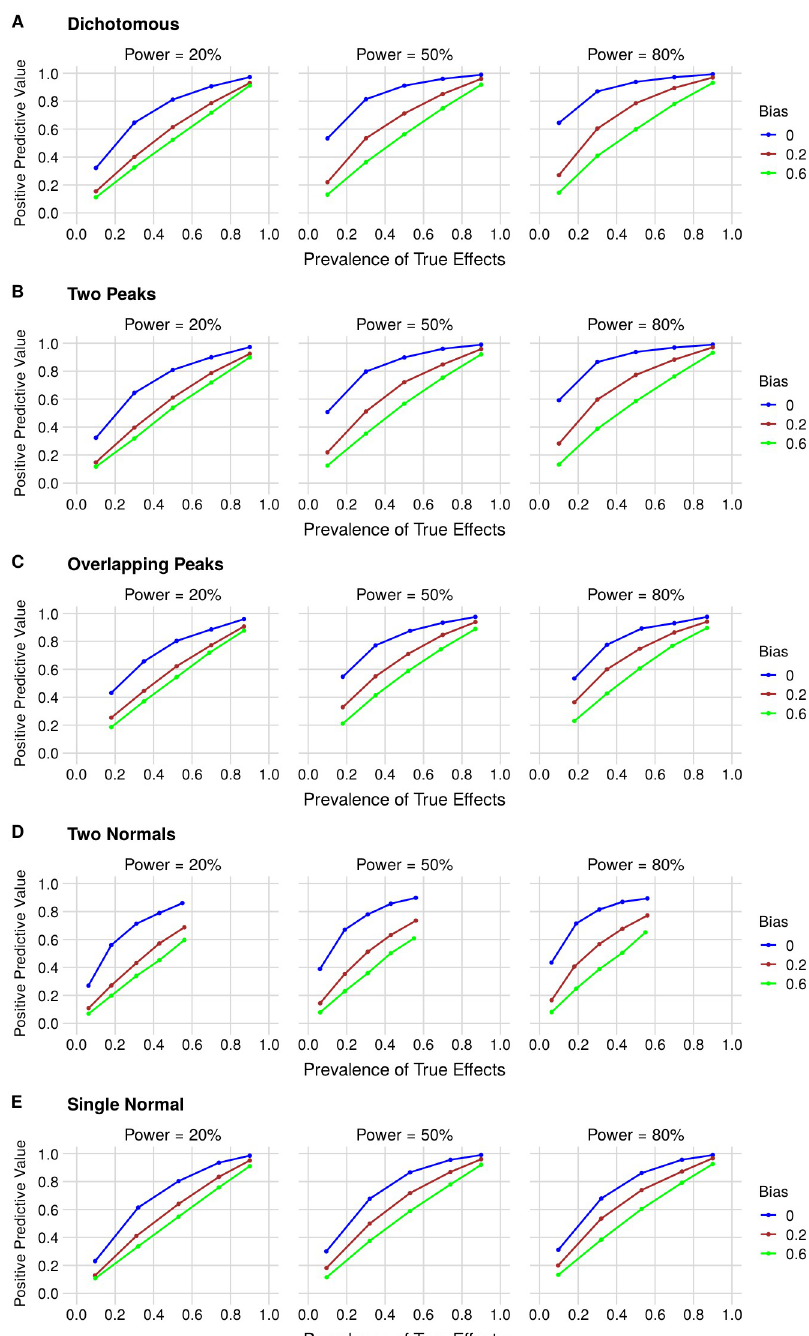
Fig 2. PPV as a function of the prevalence of true effects, statistical power and bias for (A) Dichotomous, (B) Two Peaks, (C) Overlapping Peaks, (D) Two Normals and (E) Single Normal effect size distributions. Each point corresponds to a simulation with 5,000 published findings. True effects are defined as those above the minimum of interest (Cohen’s d > 0.5 in all simulations). In each panel, graphs correspond to 20%, 50% and 80% power from left to right. Blue, red and green curves correspond to bias (i.e. prevalence of negative results that are repeated until becoming positive and then published) of 0, 0.2 and 0.6, respectively. Prevalence ranges vary among scenarios, as for some distributions some prevalences cannot be achieved without changing other parameters: in the Two Normals model in particular, one cannot obtain a prevalence above 62% unless either the SD of the wider normal or the minimum effect of interest is